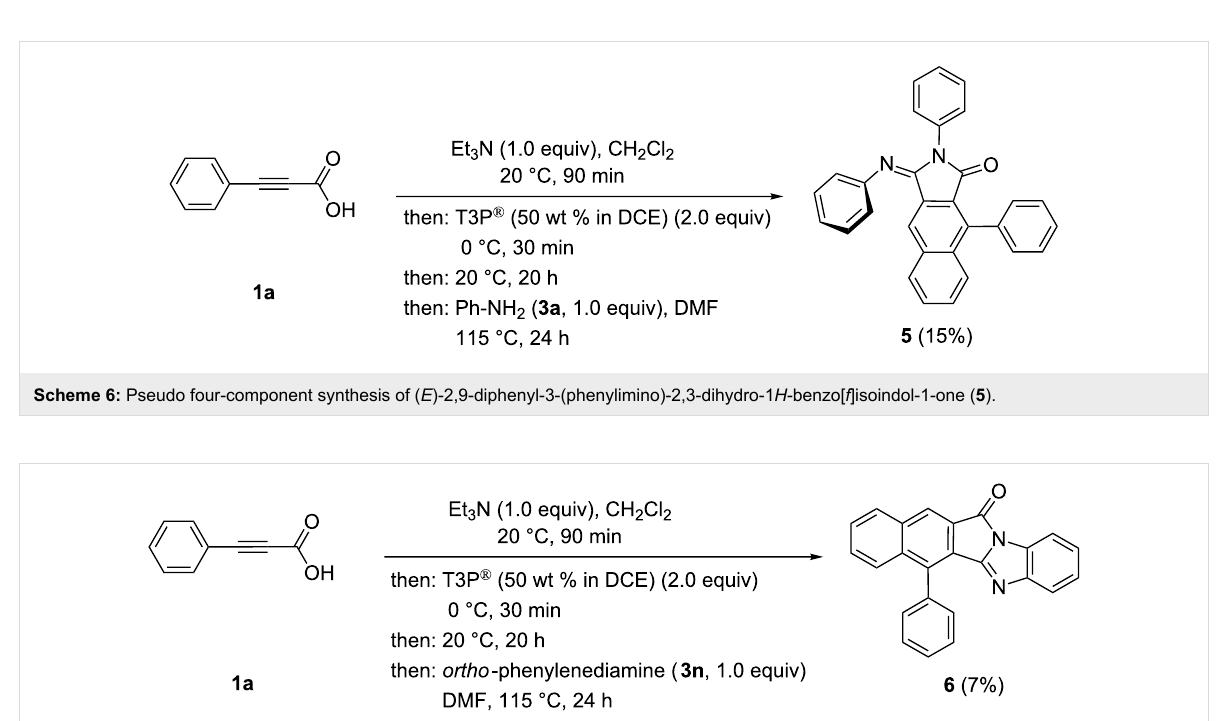
1 H -benzo[ f ]isoindole-1,3(2 H )-dione by electrophilic attack on the sterically easier accessible carbonyl group. As a conse- quence the imine condensation proceeds also with thermo- dynamic control giving exclusively the formation of the E -configured product 5 . Interestingly the corresponding reac- tion with ortho -phenylenediamine ( 3n ) gives rise to the regiose- lective formation of the pentacyclic condensation product 6 , where the intramolecular imine formation formally occurred at the sterically more biased carbonyl group (Scheme